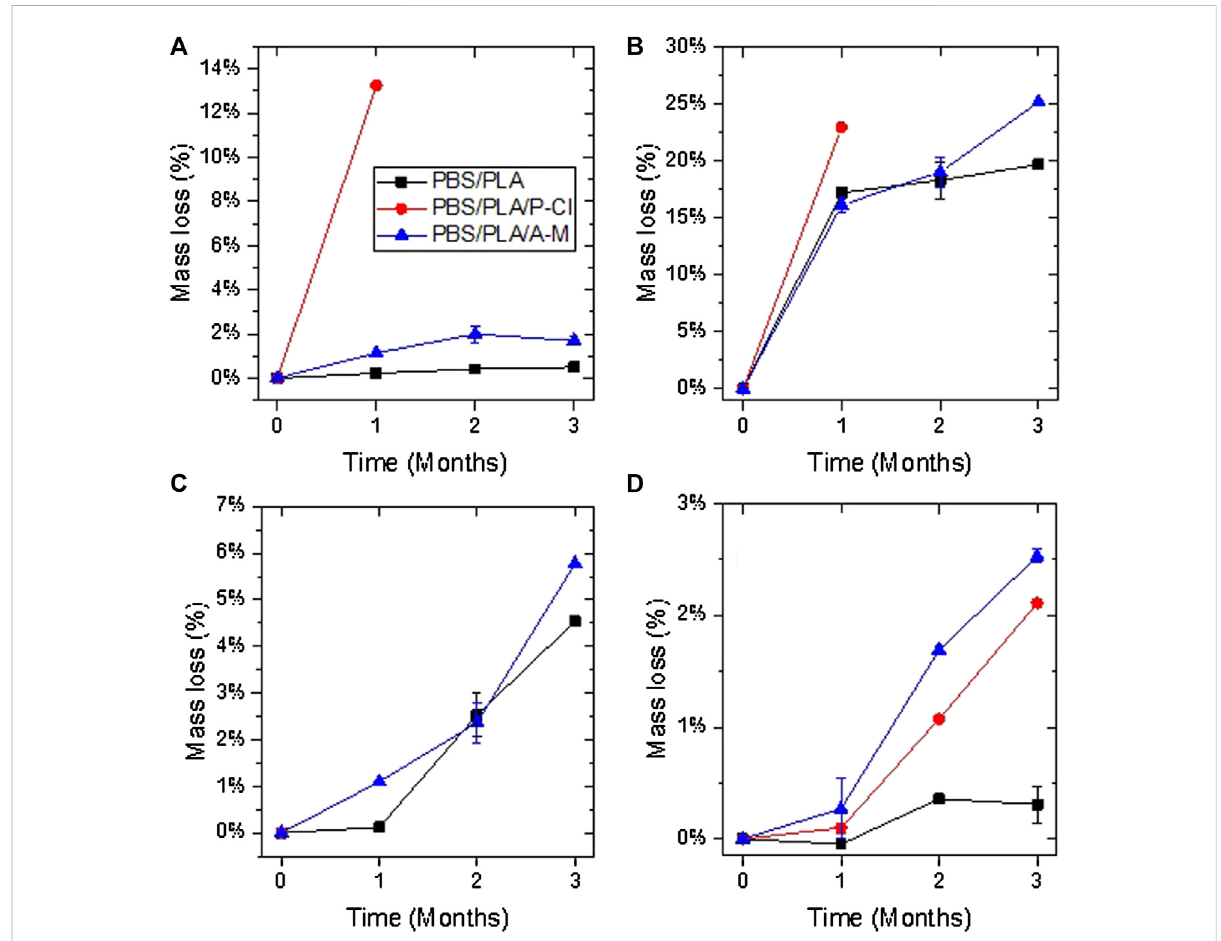
FIGURE 6 Weight loss in deionized water at 58 ° C (A) , in NaOH solution at 58 ° C (B) , under composting conditions at 58 ° C (C) , and under soil burial conditions at room temperature (D) . Results are given with standard deviation. If not shown, only one sample could be recovered and